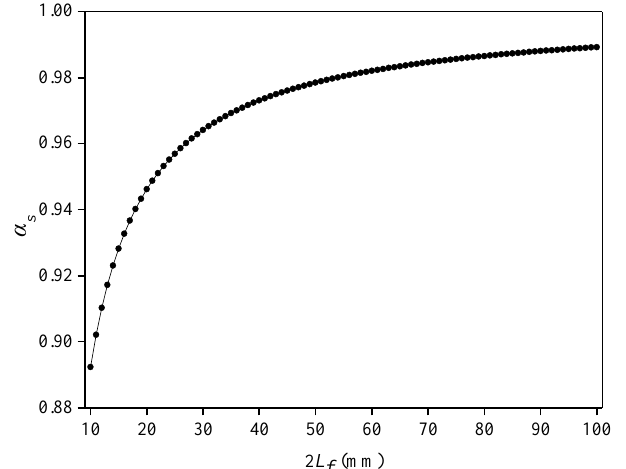
Figure 4. Relationship between length of cemented layer and average strain-transfer coefficient in surface-bonded model.